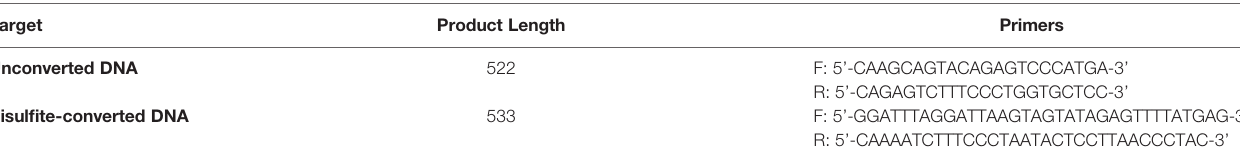
TABLE 3 | Primers for lncSnhg7 promoter ampli fi cation.